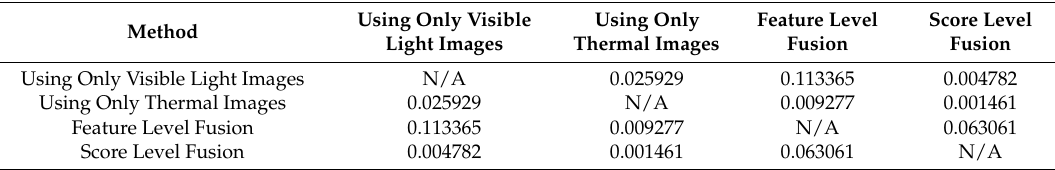
Table 11. The p -value of performances of different system’s configurations using our proposed method (N/A: Not available).